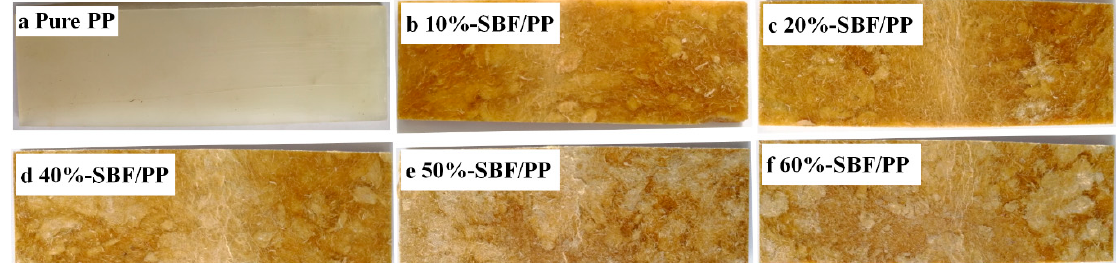
Figure 6. The modulus of rupture (MOR) and modulus of elasticity (MOE) of the pure PP and composites with different SBF contents.